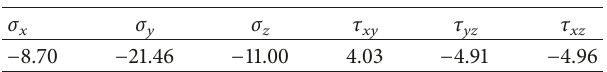
Table 11: The maximum normal stress and shear stress results (MPa).